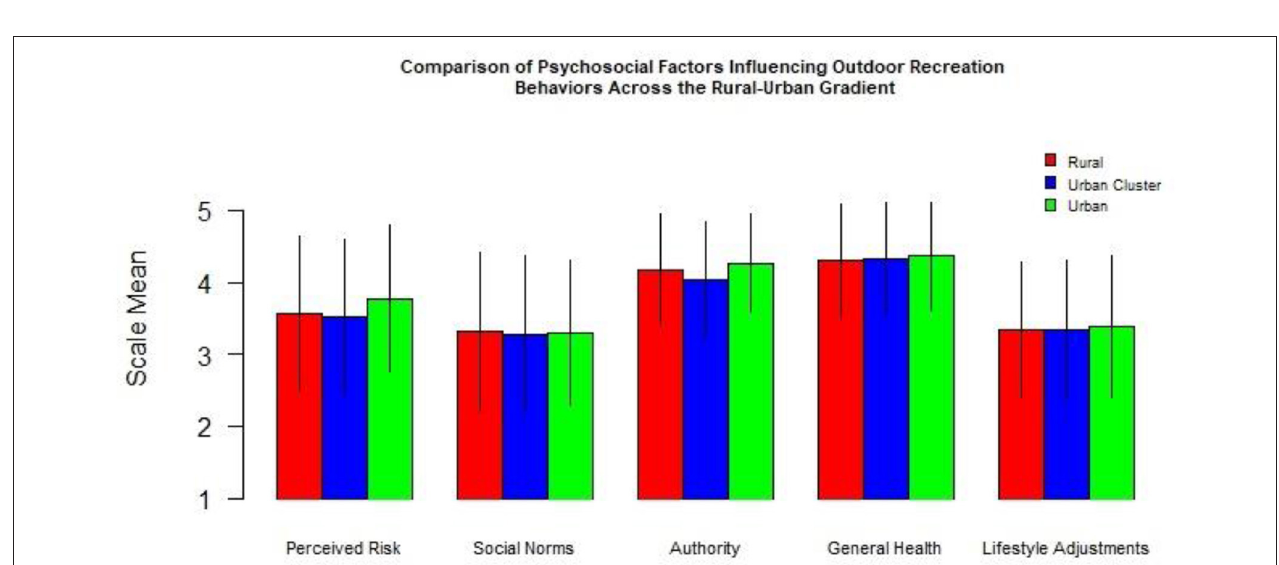
FIGURE 3 | Results from the one-way ANOVA’s examining differences amongst scale means across three community types (rural, urban cluster, and urban); omnibus tests for one-way ANOVA’s were significant across community types for Perceived Risk [ F (2,897) = 5.23, p = 0.006] and Authority [ F (2,897) = 6.79, p = 0.001]; error bars represent the standard deviation for each psychosocial